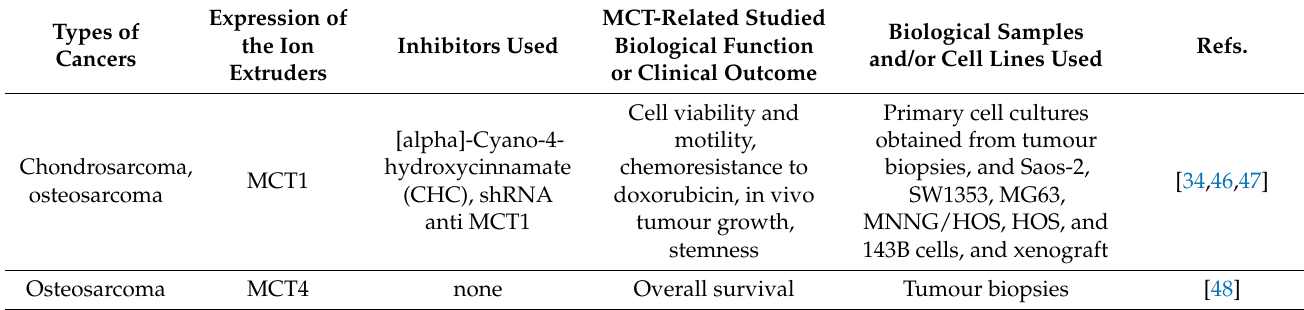
Table 3. MCT expression and targeting in bone